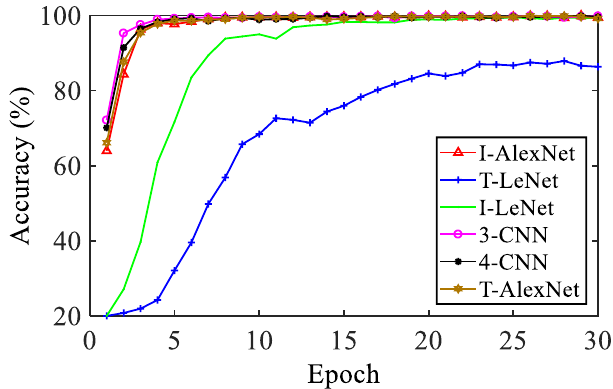
Figure 22. Curve of testing accuracy for different CNN models.